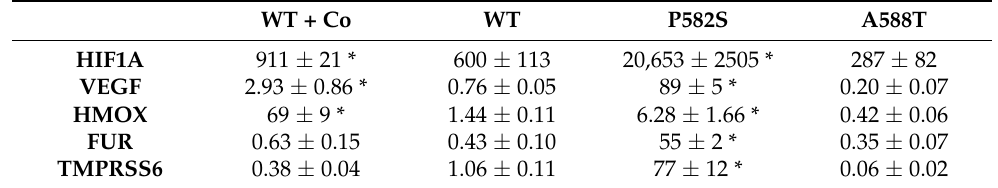
Table 4. HIF1A , VEGF , HMOX , FUR and TMPRSS6 mRNA levels expressed as the ratio between transfected and non-transfected Huh-7 cells under normoxic and hypoxic (+) conditions. All data were obtained from three independent experiments conducted in triplicate (mean ± SD).